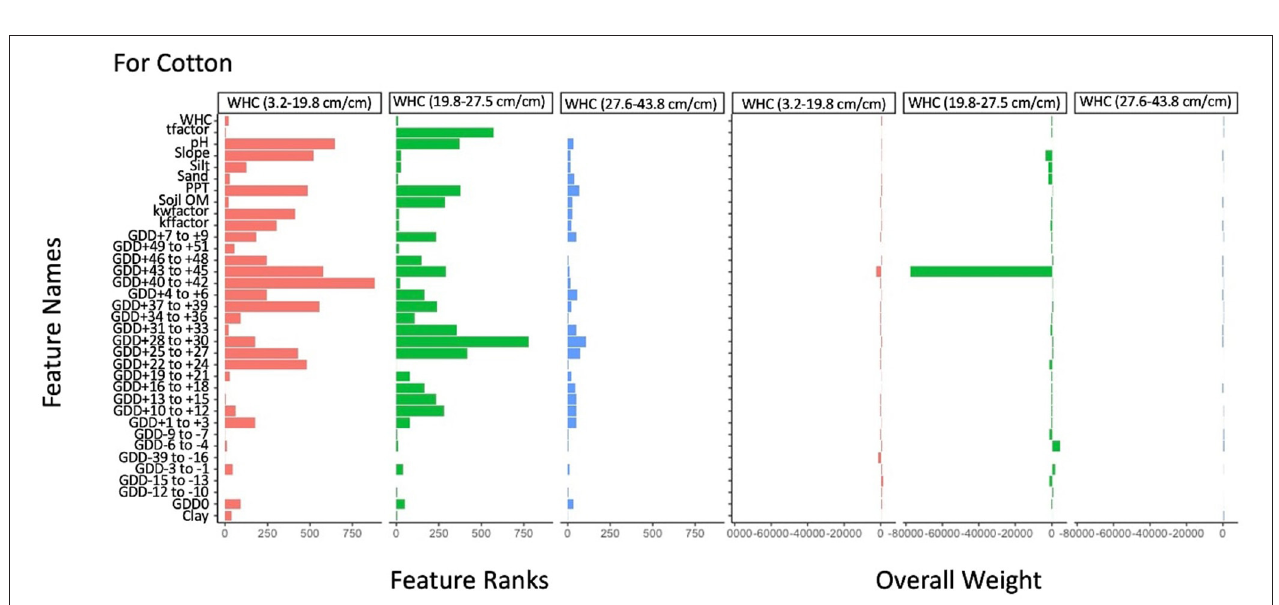
FIGURE 11 | Feature ranks and overall weight of features following explainable machine learning interpretations for soybean for low, medium, and high quartiles of water holding capacity.